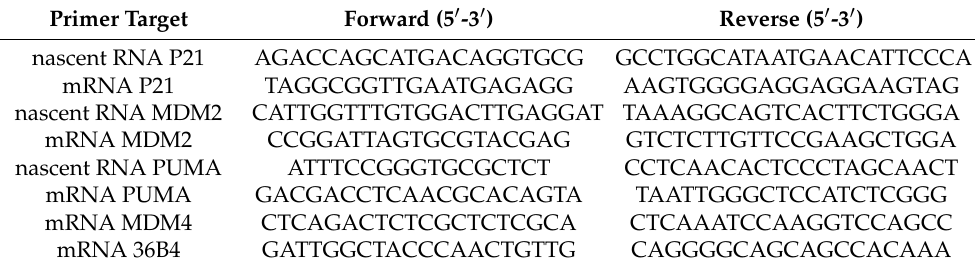
Table 2. Primer sequences for RNA